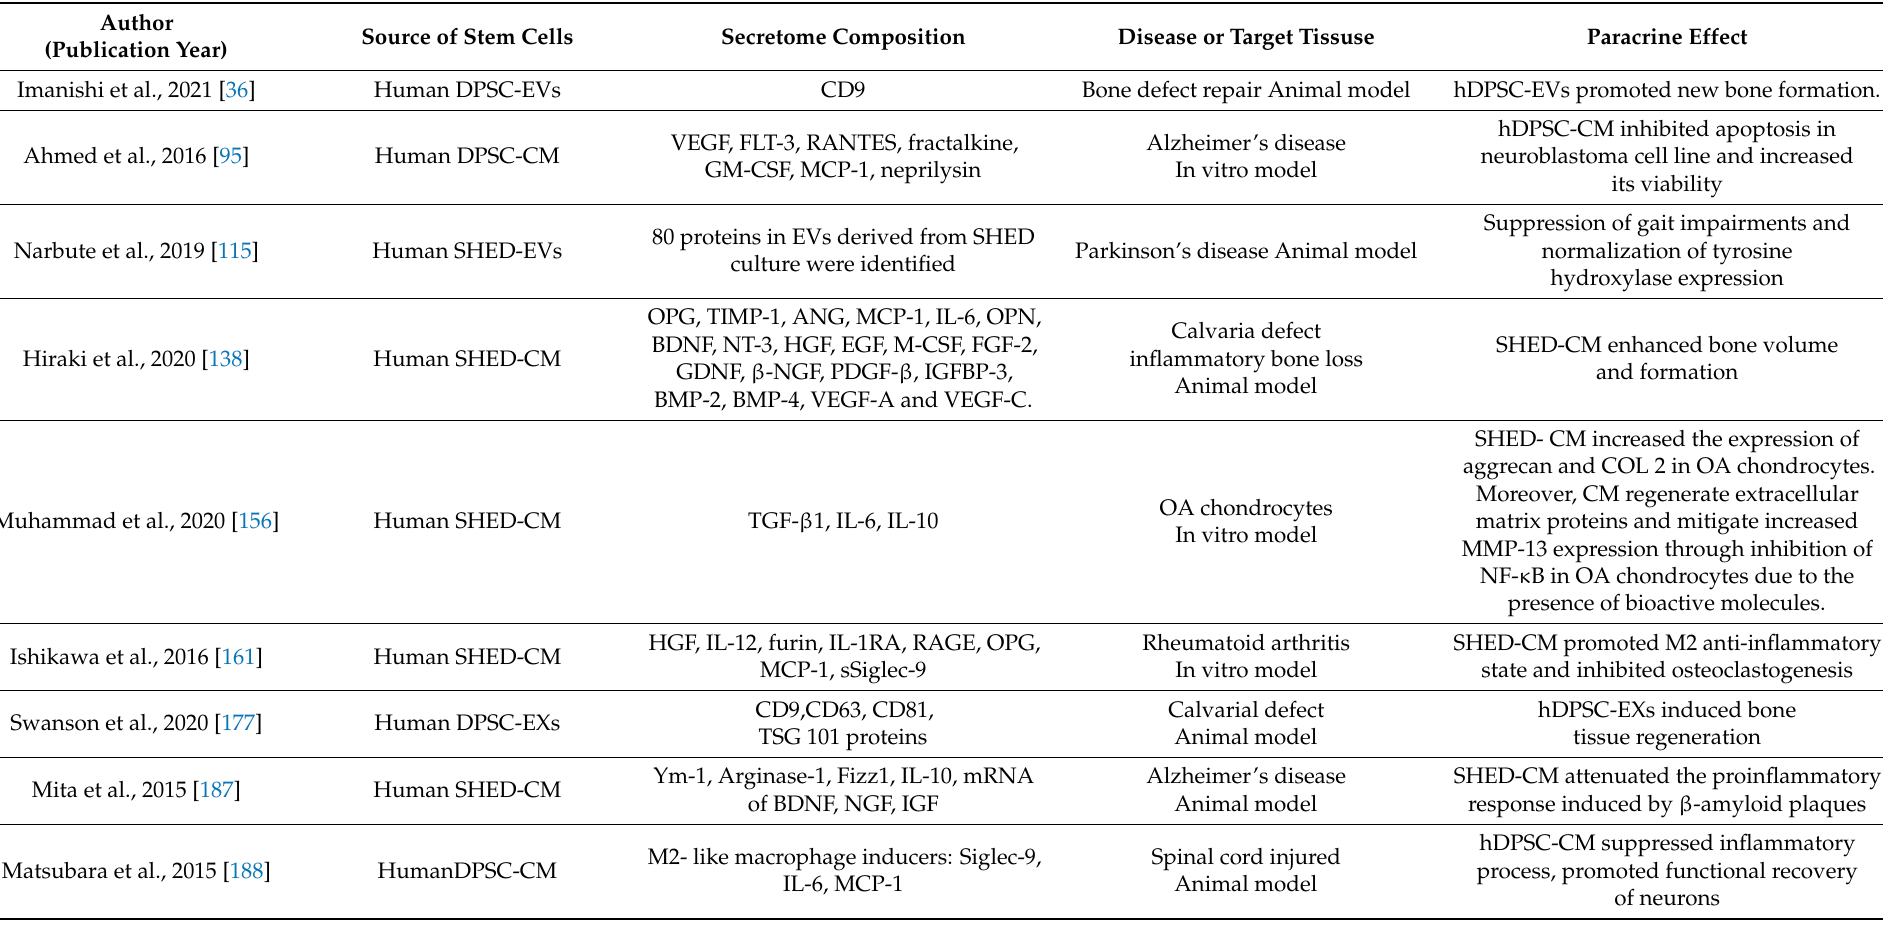
Table 3. The regenerative effect of human hDPSC and hSHED-derived secretome used in experimental